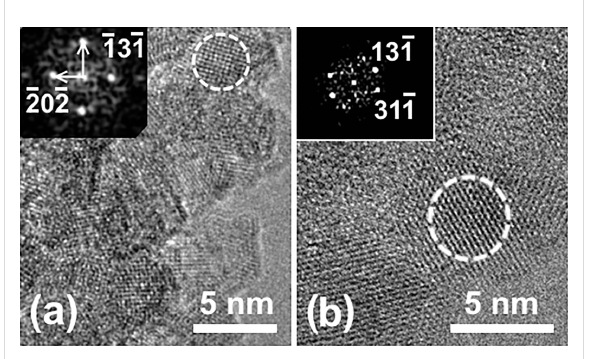
Figure 2: HRTEM images of uncoated (a) and HSA-functionalized samples (b).